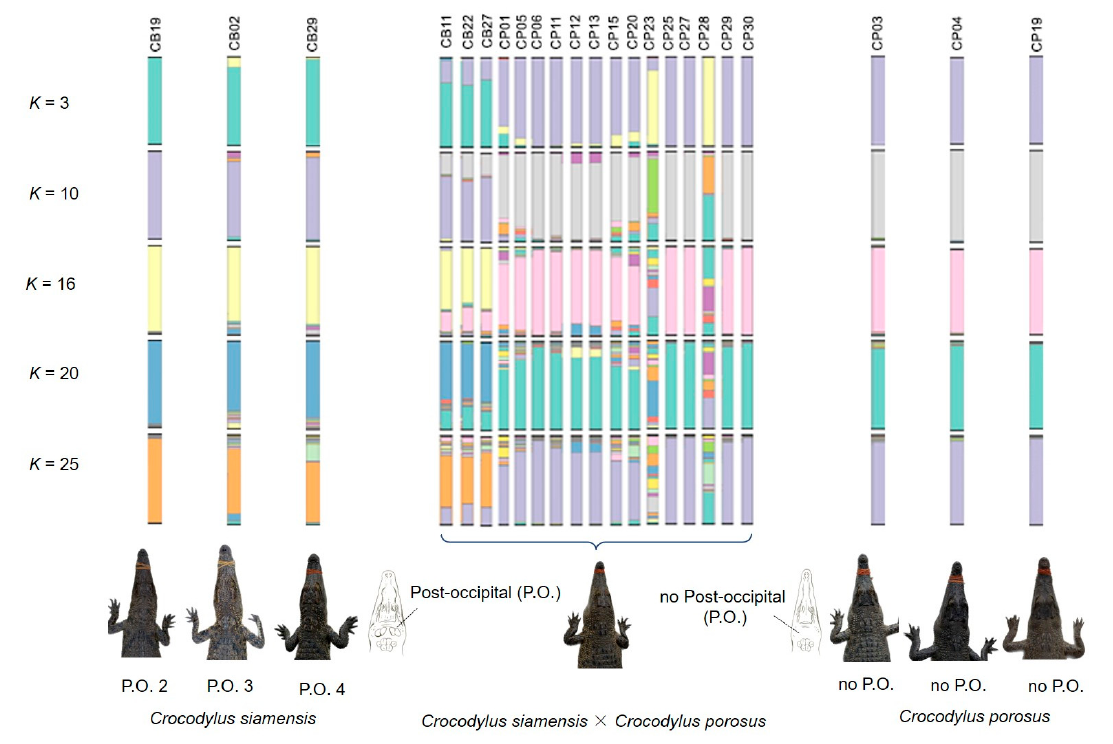
Figure 5. Representation of structure plot and post-occipital scutes (P.O.) for hybrids between Sia- mese and saltwater crocodiles ( Crocodylus siamensis × Crocodylus porosus ) and pure Siamese and salt- water crocodiles. Detailed information for all hybrids between Siamese and saltwater crocodile in- dividuals is presented in Figures 3 and S3. is presented in Figures 3 and